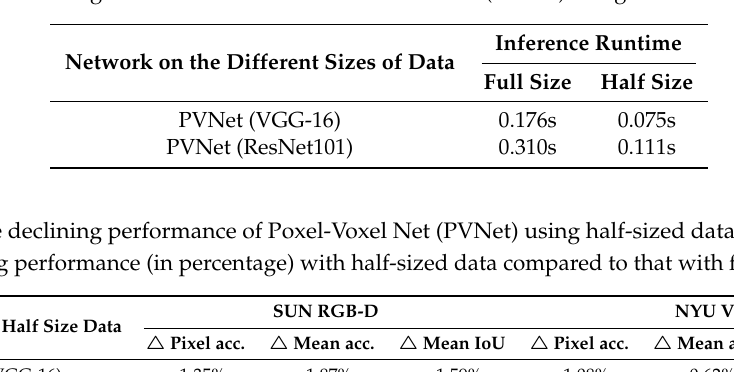
Table 5. The average inference runtime of Pixel-Voxel Net (PVNet) using different sizes of data.